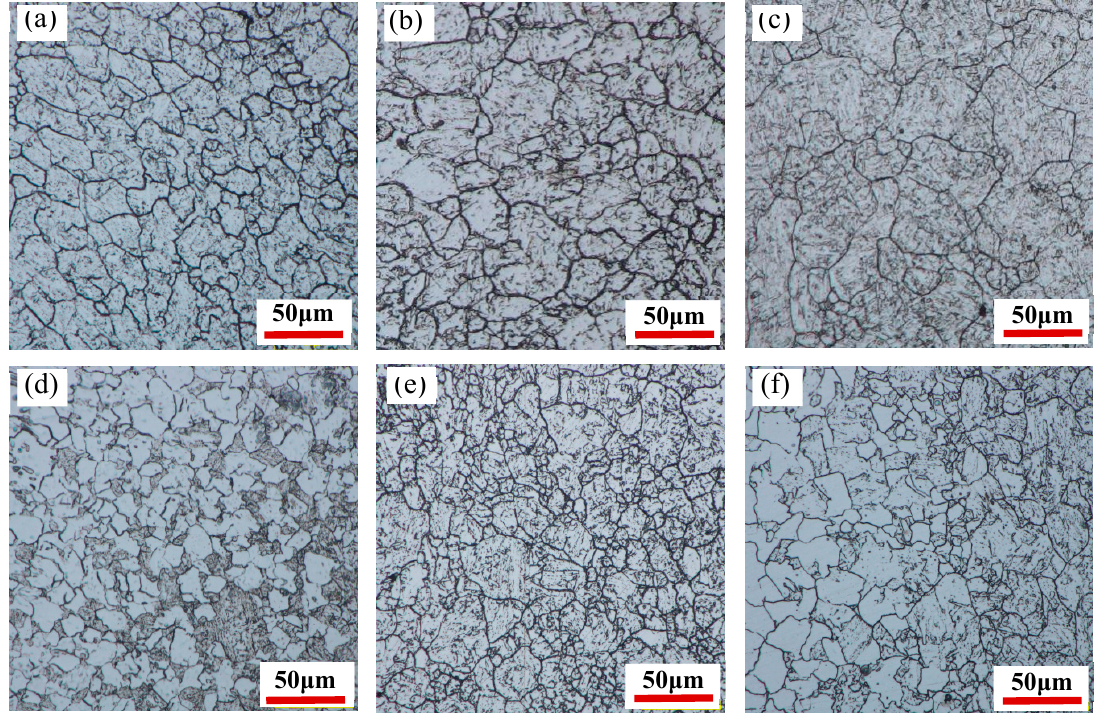
Figure 2. Microstructure of 35CrMoV steel at different deformation temperatures and strain rates: ( a ) 0.01 s − 1 , 850 °C; ( b ) 0.01 s − 1 , 950 °C; ( c ) 0.01 s − 1 , 1050 °C; ( d ) 10 s − 1 , 850 °C; ( e ) 10 s − 1 , 950 °C; ( f ) 10 s − 1 , 1050 °C.